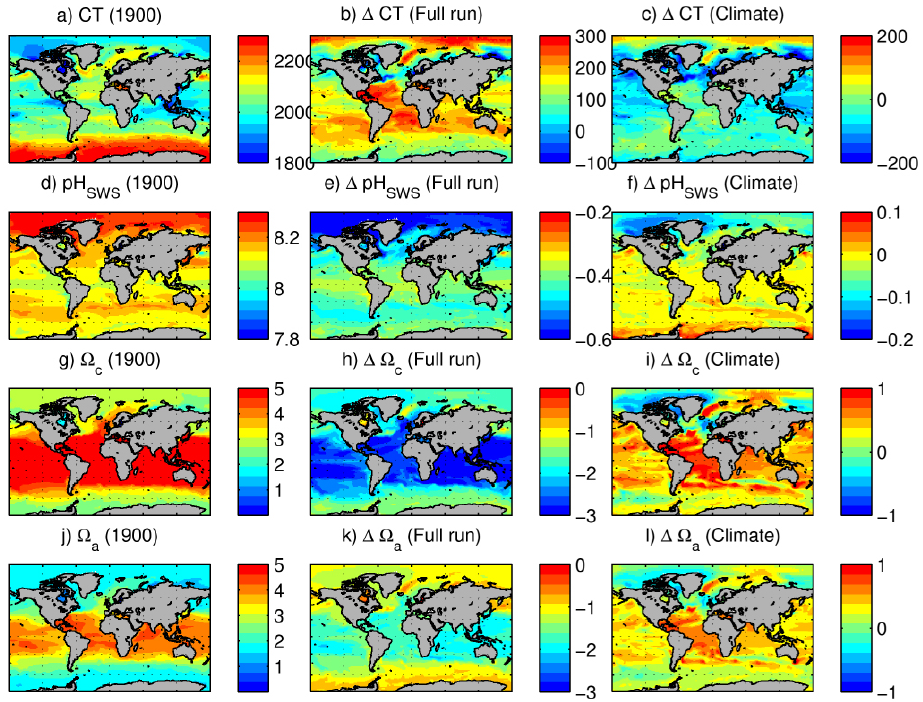
Fig. 10. Global surface maps of DIC (mmolm − 3 ) (a–c) , pH SWS (d–f) , (cid:127) c (g–h) and (cid:127) a (j–l) . The first column shows values for year 2000; the second column shows deviation between year 2099 and year 2000 for the full run, and the third column shows deviation between year 2099 and year 2000 for the climate change